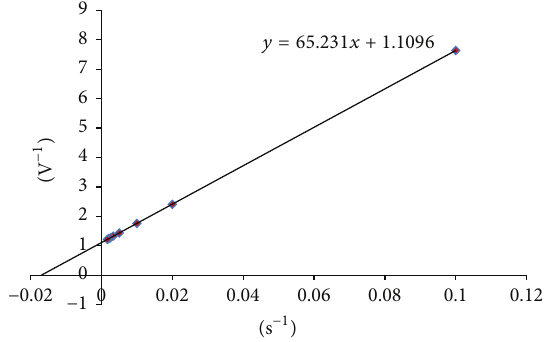
Figure 11: Lineweaver-Burk plot of the present method.